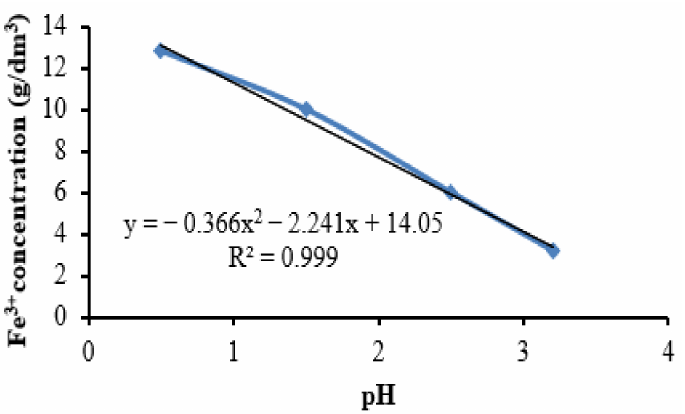
Figure 4. Dependence of Fe(III) content in solution on the pH of the solution.